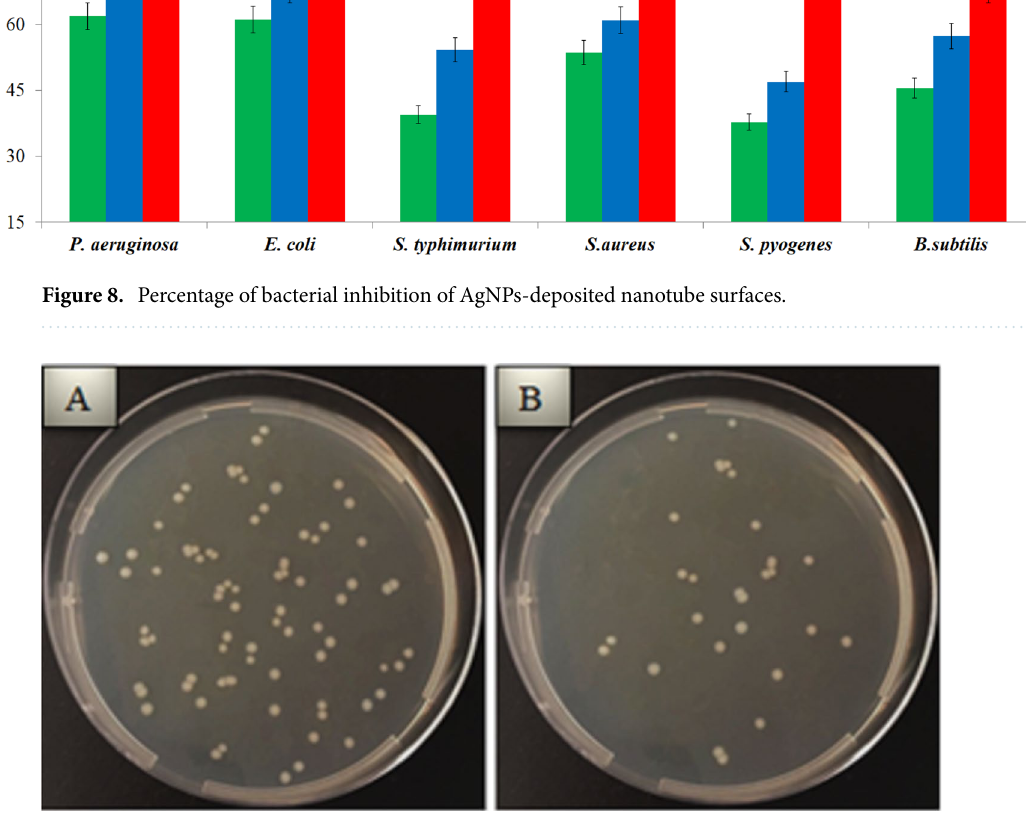
Figure 9. Reduction in bacterial colonies after re-culturation in samples with the highest antibacterial activity on AgNPs-deposited surfaces ( A ) S. typhimurium viability after re-culture on bare Gr2 surfaces, ( B ) S. typhimurium viability after re-culture on Gr2-50 V-Ag-5 m